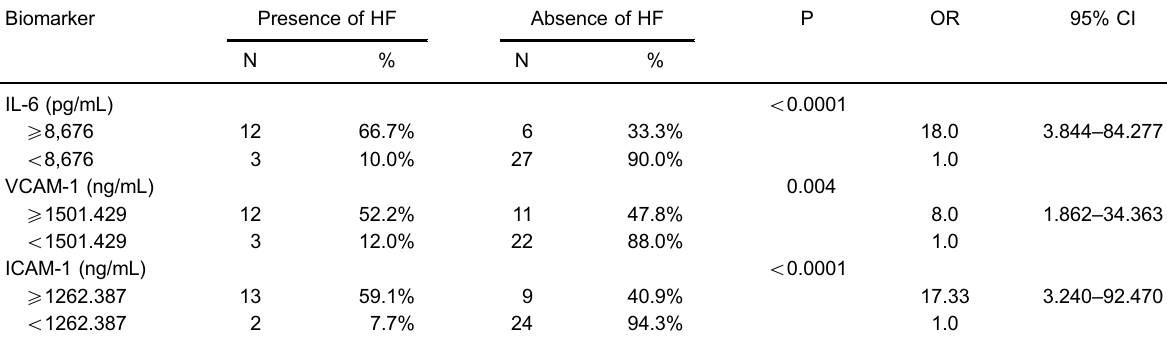
Table 2. Association between established cutoff points for IL-6, VCAM-1, and ICAM-1 with the presence of new heart failure post-acute myocardial infarction (HF). Biomarker Presence of HF